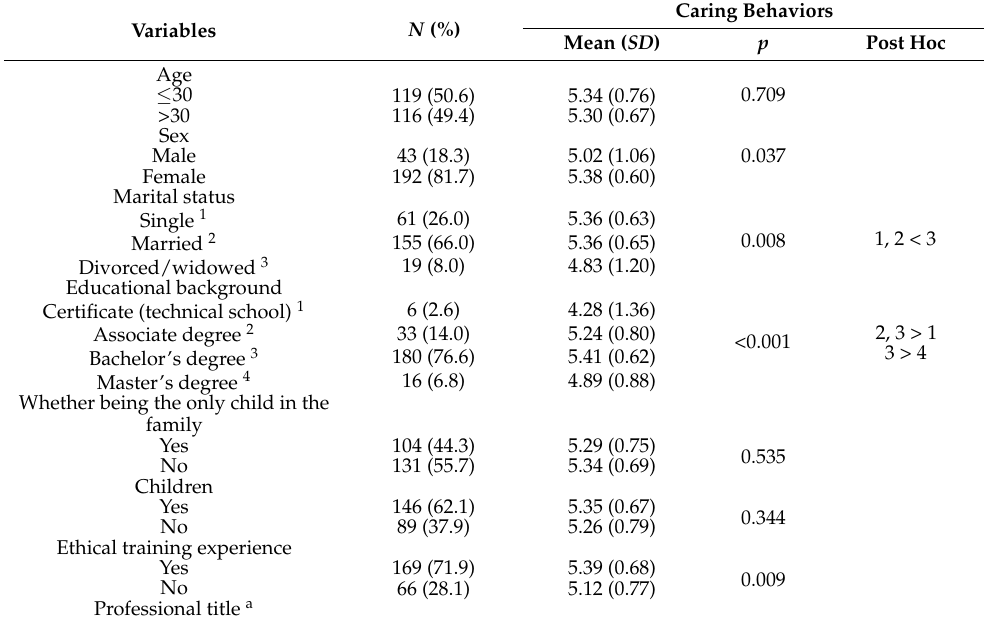
Table 1. Association between general information variables and nurses’ self-evaluated caring behav- iors ( n =